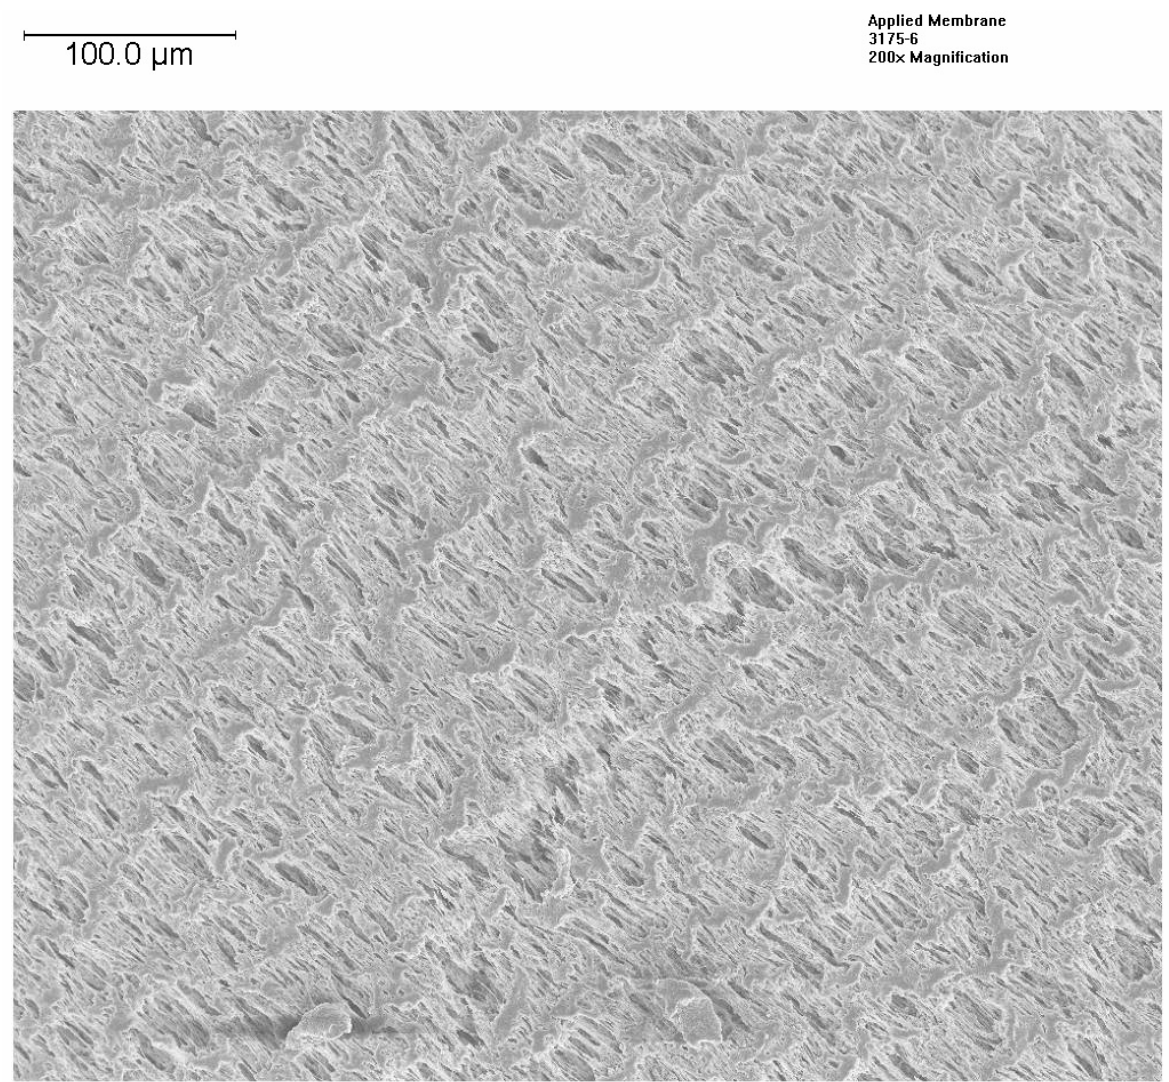
Figure 4. SEM of Plasma Polymer Coated PP150/330 HFM.